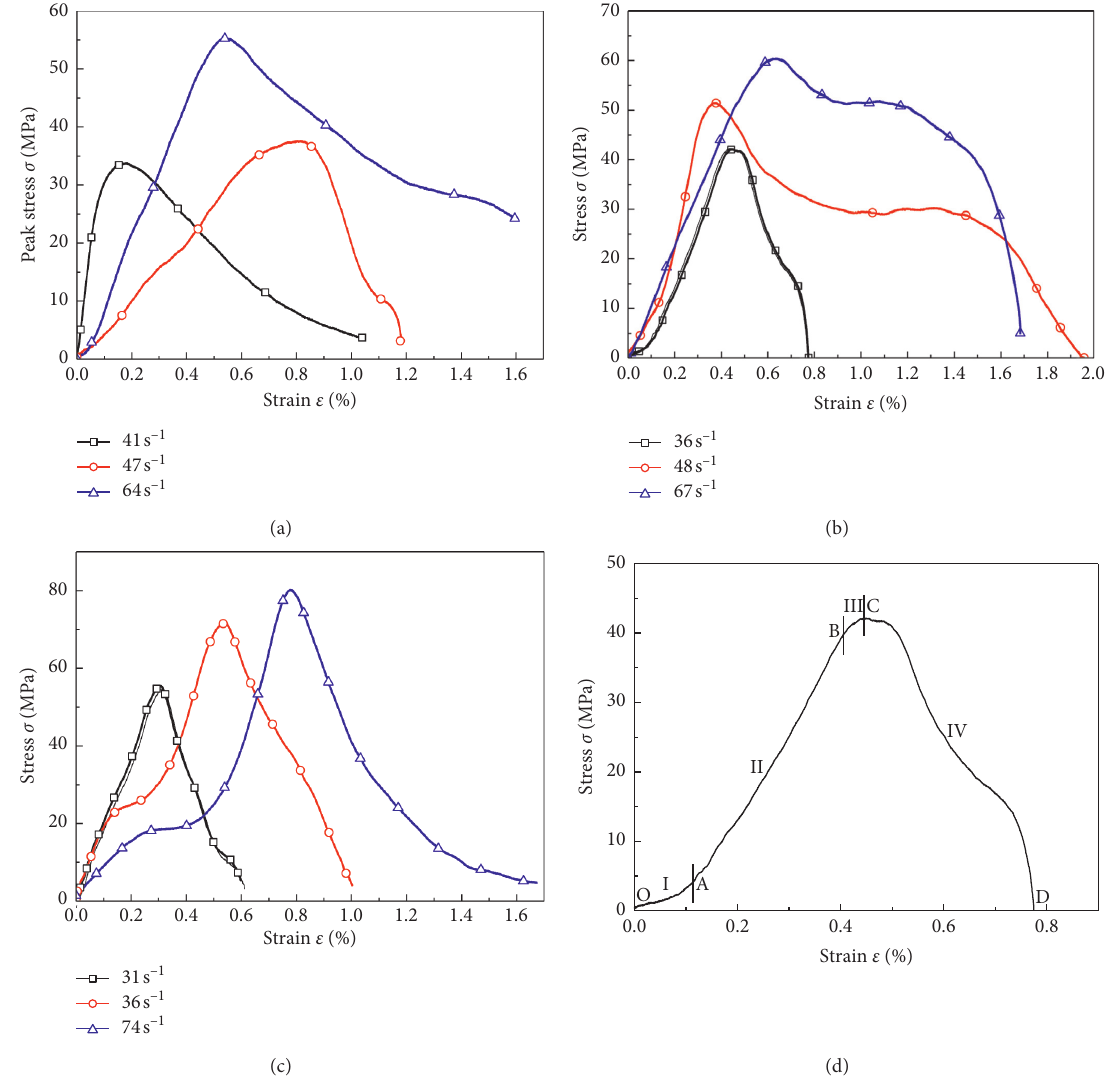
Figure 5: Typical strain-stress curves. (a) − 15 ° C. (b) − 20 ° C. (c) − 30 ° C. (d) The different